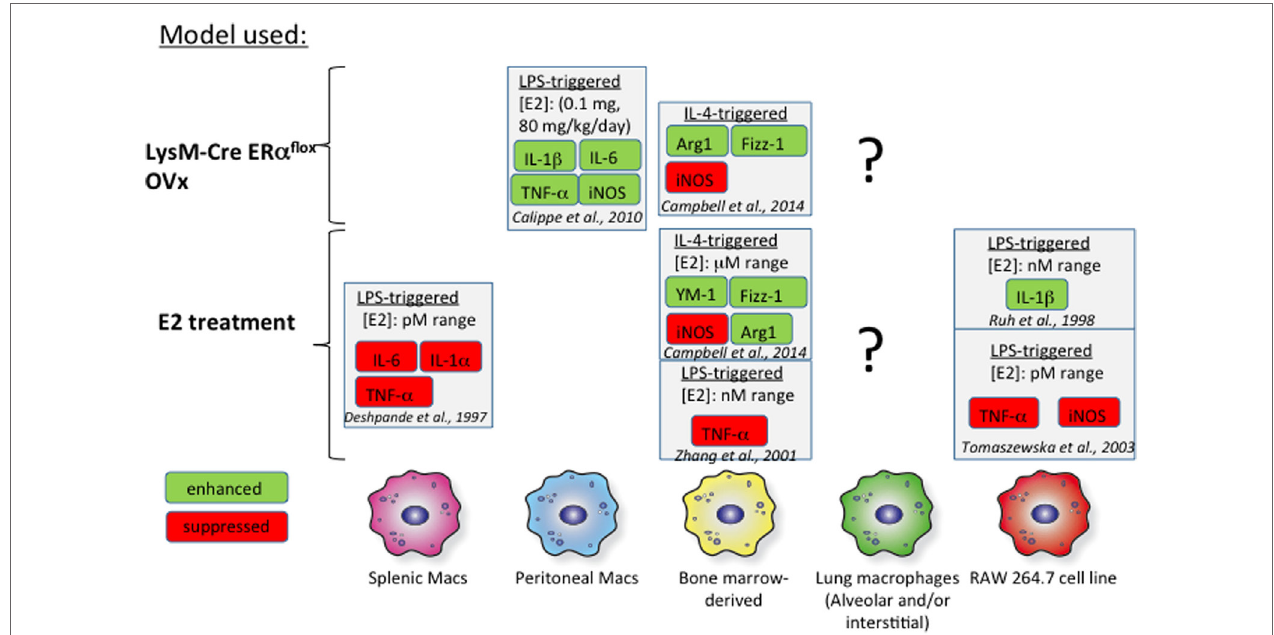
FiGURe 2 | effects of estrogen in vitro on macrophages . The effects of estrogen on macrophages from various tissues are illustrated above. The findings of several studies are summarized and referenced in the figure. The effects of estrogen on proinflammatory mediators are highly dependent on the tissue of origin. There is a general lack of data focusing on the impact of estrogen signaling on alveolar macrophages, indicated by the question